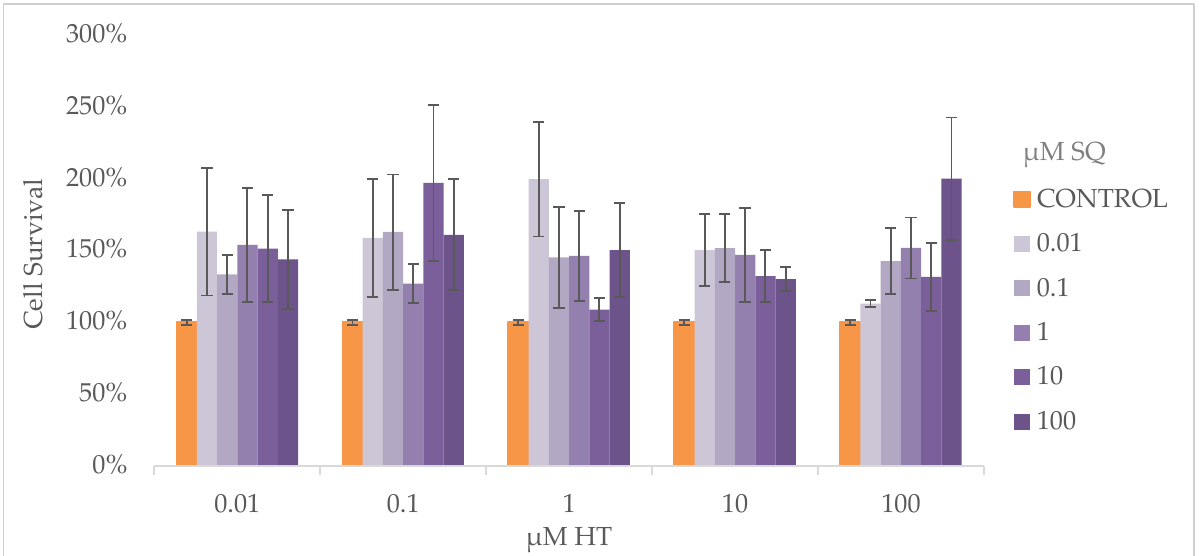
Figure 1. Cytotoxicity of HT–SQ from 0.01 µ M to 100 µ M in MDA-MB-231 cells. Data are represented as mean ± SEM of 3 independent experiments.